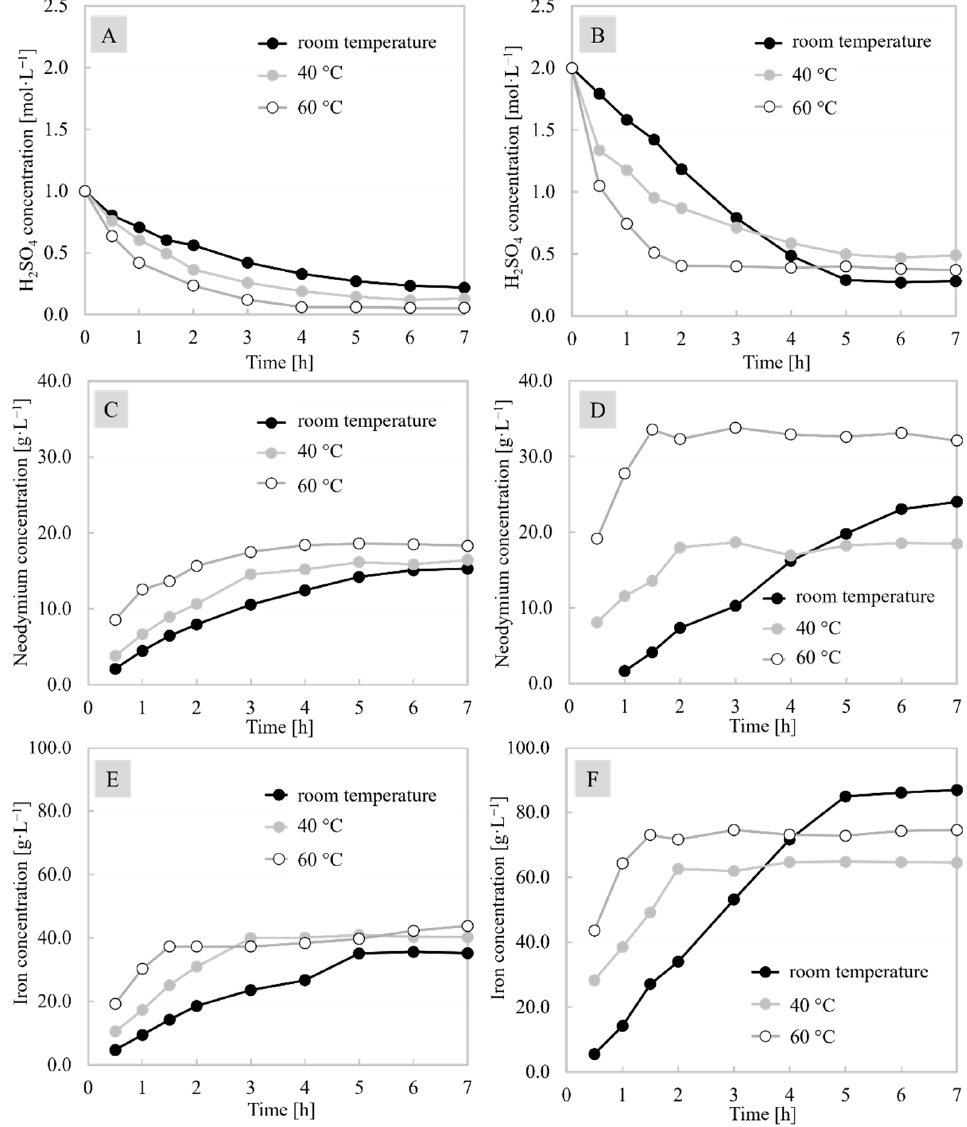
Figure 4. Leaching of demagnetized and broken NdFeB magnets in 1 M H 2 SO 4 solution (left side) and in 2 M H 2 SO 4 solution (right side). Different figures show the dependence between leaching time and the concentration of H 2 SO 4 ( A , B ), neodymium ( C , D ) and iron ( E , F ).